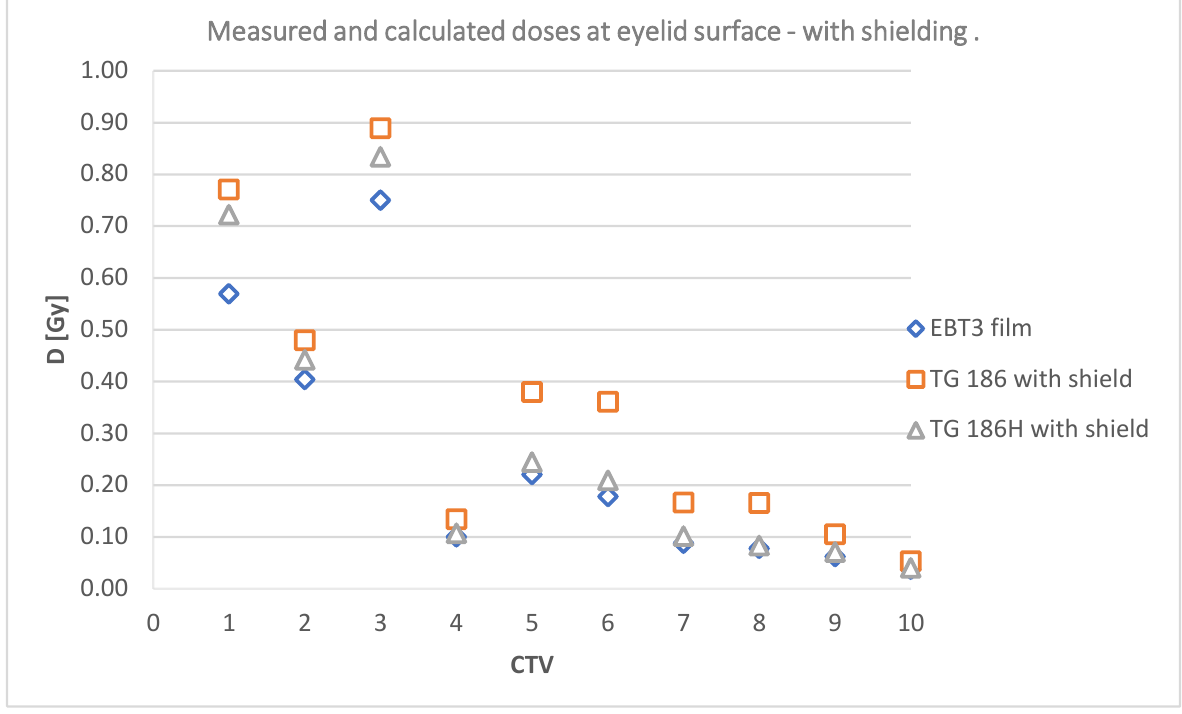
Table 5. Doses measured at a point in the lens of the eye—with a shield. POINT NO.